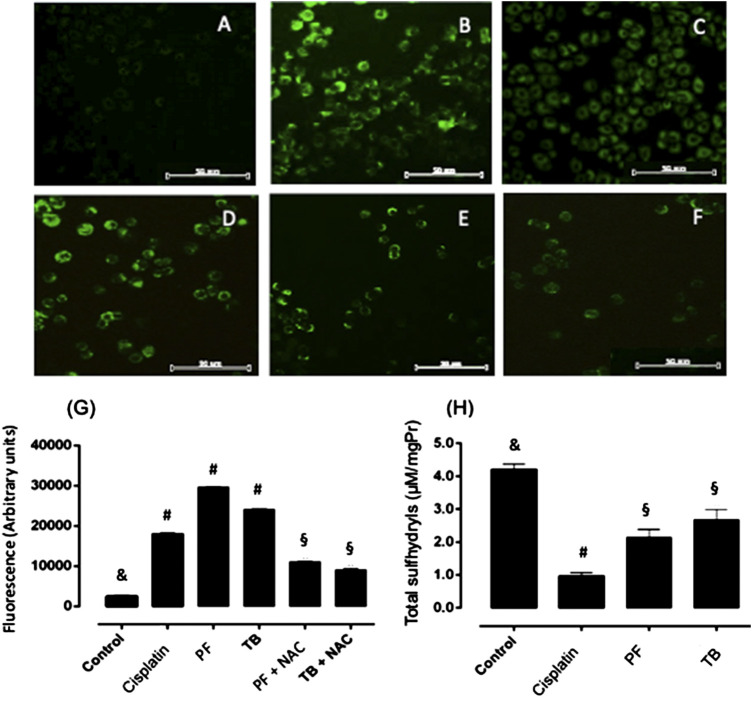
Intracellular reactive oxygen species generation and sulfhydryl levels in HCT15 cells after 24 h of exposure to the polyphenolic fraction and thalassiolin B from T. testudinum extract (at IC50 values). (A) control cells; (B): cisplatin (10 µM); (C): polyphenolic fraction; (D): thalassiolin B; (E): N-acetylcysteine + polyphenolic fraction; (F): N-acetylcysteine + thalassiolin (B). Bars represent mean ± standard deviation of fluorescence arbitrary units (G,H). Two independent experiments by triplicate were carried out. Different symbols on bars represent statistical differences (ANOVA, Tukey post-hoc, p < 0.05).